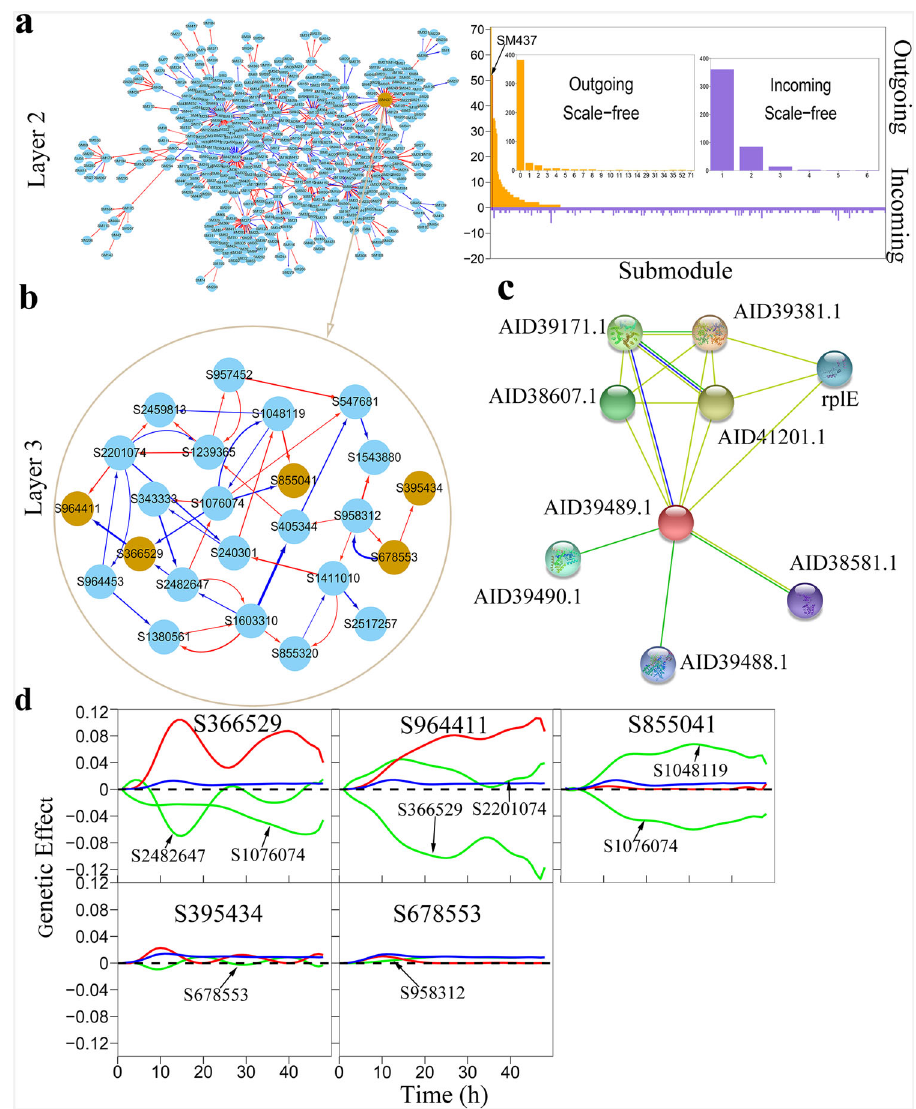
Fig. 5 The second- and third-layer networks of module M4 containing no QTL. a Left panel: The 464-node inter-submodule network at the second layer under network community M4 of the fi rst-layer network. Right panel: Distribution of the number of outgoing and incoming links over 464 submodules whereas one of the leaders SM437 is indicated. Within the distribution plot, two smaller plots show the power distribution of the frequency of outgoing and incoming links. b The 24-node inter-SNP network at the third later under leader submodule SM437 of the second-layer network M4. c Interaction network among proteins (with names indicated) annotated from SNP network, where the strength of protein interaction is proportional to the thickness of linked line. d Curves of genetic effects on phenotypic plasticity for insigni fi cant SNPs chosen from the third-layer network in ( b ). Net genetic effect (blue line) is decomposed into independent effect (red line) and dependent effects (green line) due to regulation by other